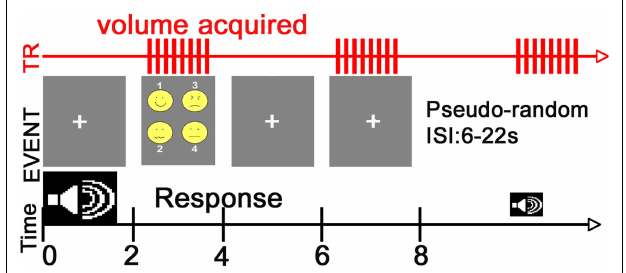
FIGURE 1 | fMRI Paradigm. Subjects were placed in a supine position into the scanner and instructed to focus on a central fi xation crosshair displayed via a rear-mounted projector [PowerLite 7300 video projector (Epson America, Inc., Long Beach, CA, USA)] and viewed through a head coil-mounted mirror. After sound offset, this crosshair was replaced with a visual prompt containing emoticons representing the four emotion choices and the corresponding response button number. Auditory stimuli were presented through pneumatic headphones and sound presentation occurred between volume collections to minimize any potential impact of scanner noise on stimulus processing.